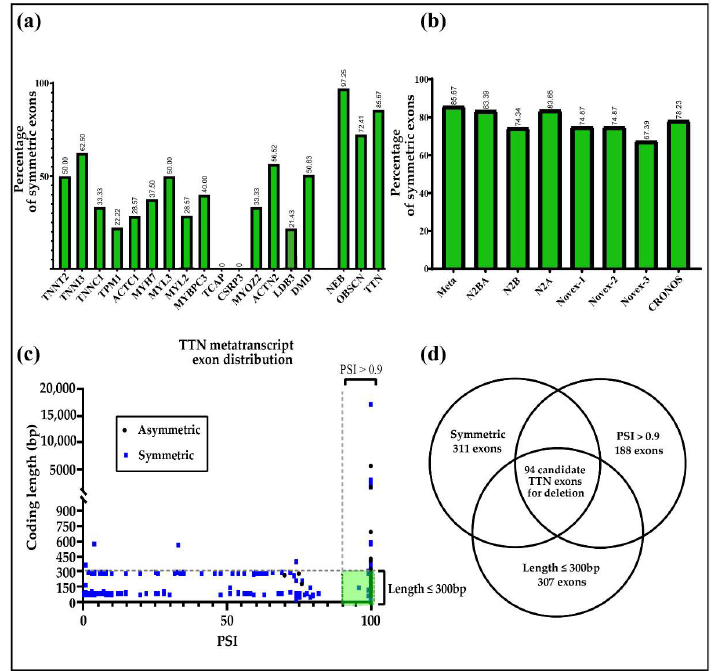
Figure 1. ( a , b ) Percentage of symmetric exons. ( a ) Percentage of protein-coding symmetric exons in different cardiac genes. TNNT2 (8 symmetric exons/16 exons in total; 50%), TNNI3 (5/8; 62.5%), TNNC1 (2/6; 33.33%), TPM1 (2/9; 22.22%), ACTC1 (2/7; 28.57%), MYH7 (15/40; 37.5%), MYL3 (3/6; 50%), MYL2 (2/7; 28.57%), MYBPC3 (14/35; 40%), TCAP (0/2; 0%), CSRP3 (0/7; 0%), MYOZ2 (2/6; 33.33%), ACTN2 (11/21; 52.38%), LDB3 (3/14; 21.43%), DMD (40/79; 50.63%), NEB (177; 182; 97.25%), OBSCN (84/116; 72.41%), and TTN (311/363; 85.67%). ( b ) Percentage of symmetric protein-coding exons in the major TTN isoforms. Meta-transcript (311 symmetric exons/363-coding exons in total; 85.67%), N2BA (261/313; 83.38%), N2B (142/191; 74.34%), N2A (261/312; 83.65%), Novex-1 (143/191; 74.87%), Novex-2 (143/192; 74.86%), Novex-3 (30/46; 67.39%) and Cronos (97/124; 78.22%). Accession numbers of the different sequences can be found in (Tables S2 and S3). ( c ) Plot representing coding length versus the percentage of splice in of the different exons in TTN (ENST00000589042). Blue squares represent symmetric exons and black dots asymmetric exons. Limits of the exons’ size (of ≤300 bp) and PSI threshold of >0.9 are marked by dotted lines. The green square contains the exons highly suitable for removal according to the criteria set in this hypothesis. ( d ) Venn diagram of the parameters set for the identification of target exons. Selected exons are symmetric, have a high PSI (>0.9) value, and consist of 300 bp at a maximum.